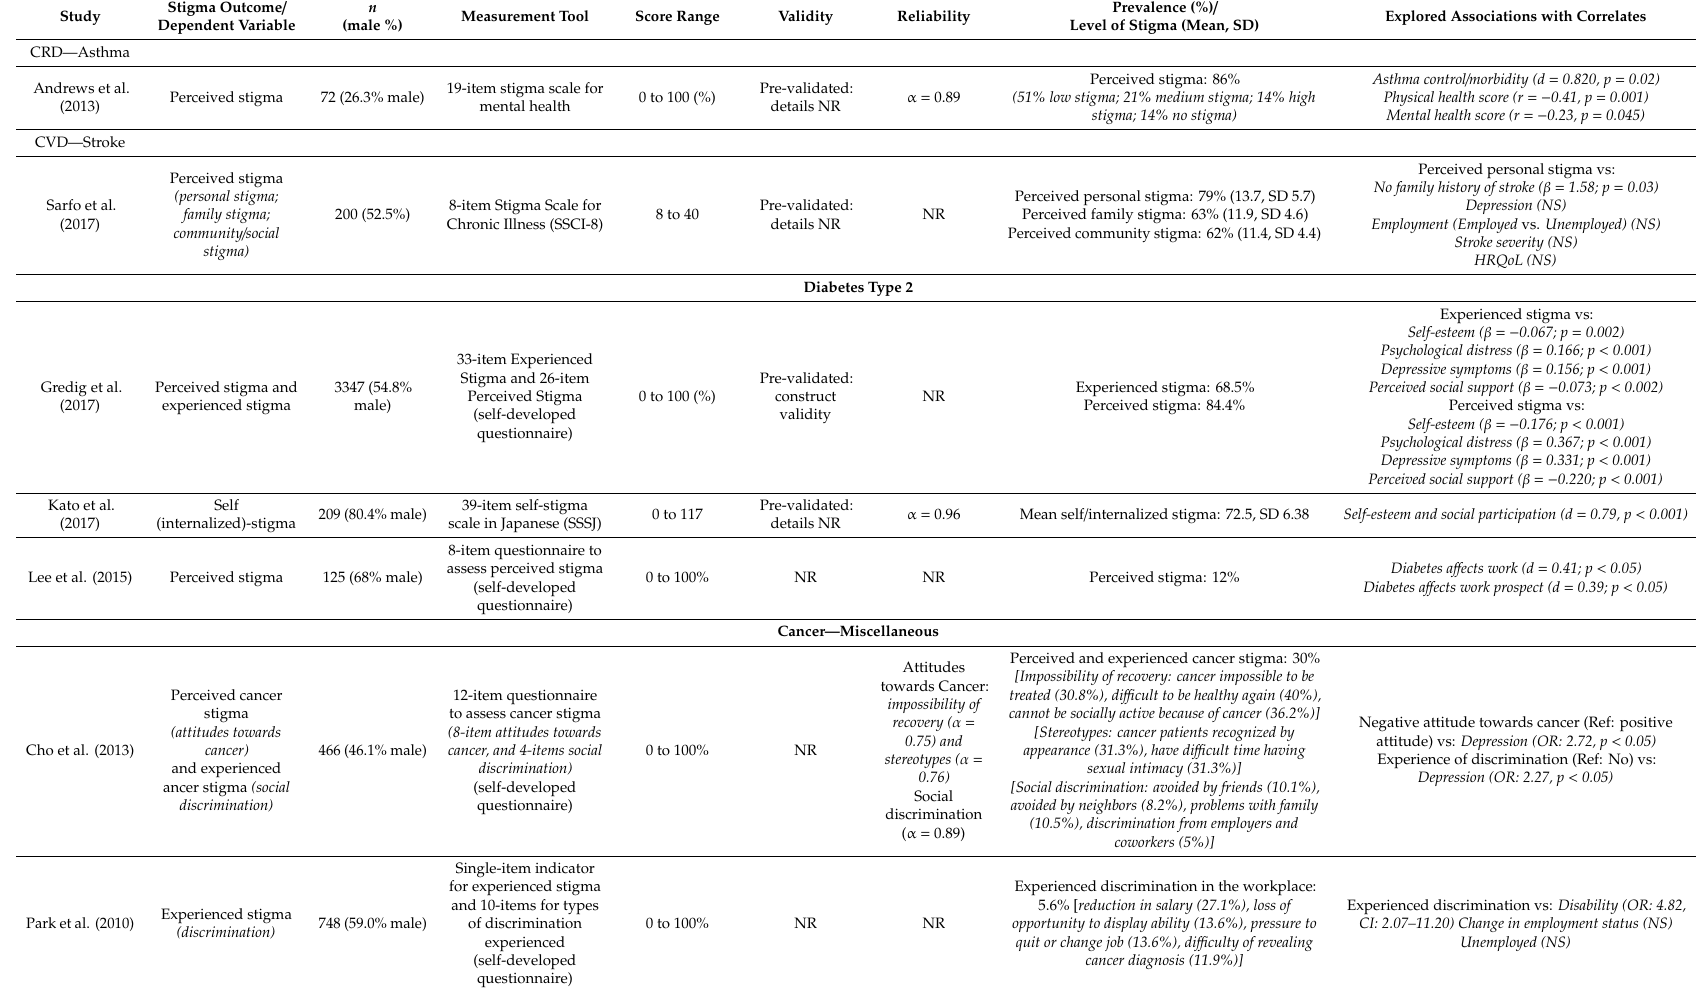
Table 3. Prevalence and / or levels, measurement tools, and correlates of NCD-related